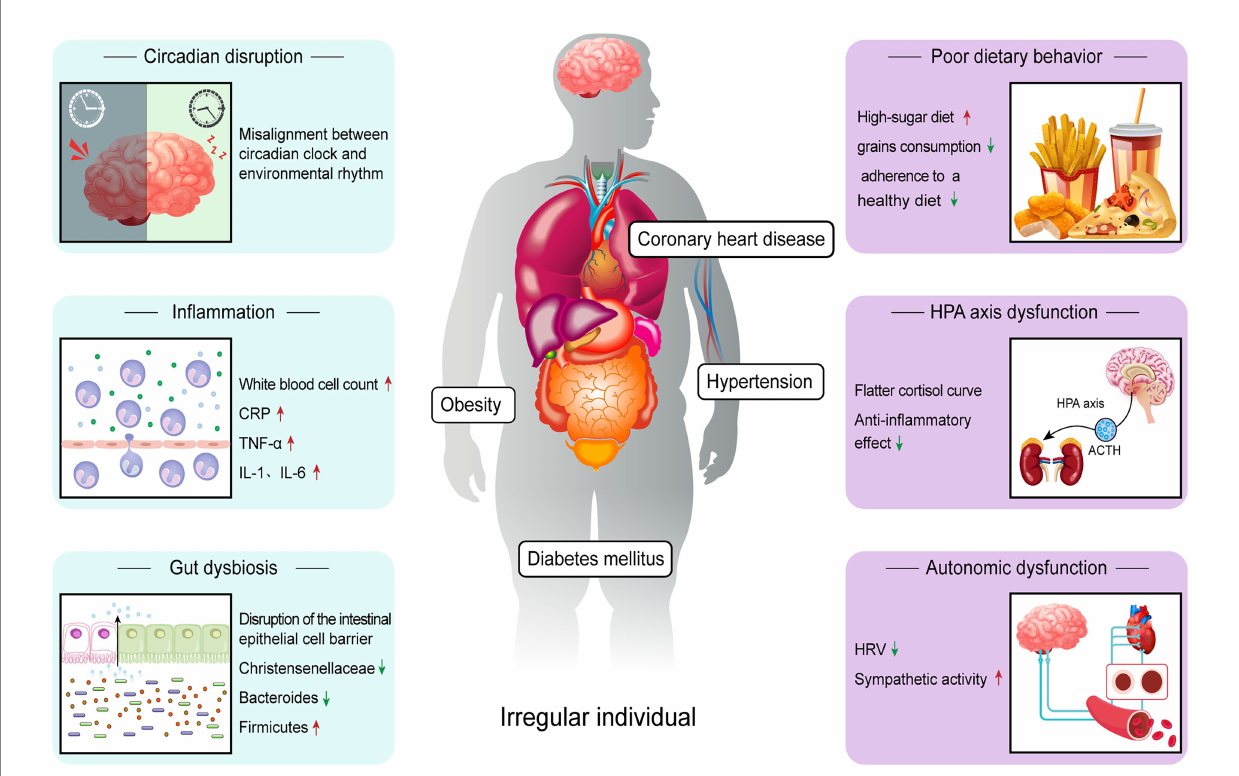
FIGURE 1 Relevant mechanisms through which irregular sleep increases risk of cardiometabolic disease. Irregular sleep induces changes in a variety of pathophysiological processes, including circadian disruption, autonomic dysfunction, inflammation, poor dietary behavior, HPA axis dysfunction and gut dysbiosis. Among them, circadian rhythm disturbance is considered to be the central